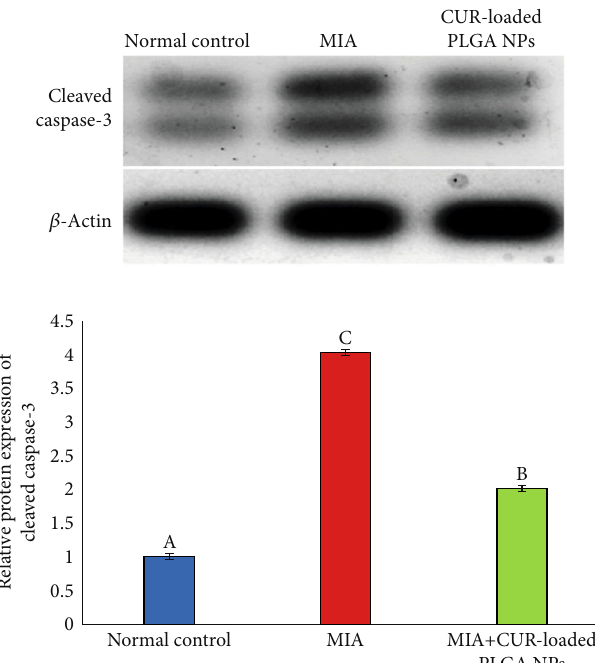
Figure 8: E ff ect of CUR-loaded PLGA NPs on the relative protein expression level of cleaved caspase-3 of MIA-induced OA rats. Means, which have di ff erent symbols (letters), are signi fi cantly di ff erent at P < 0 : 05